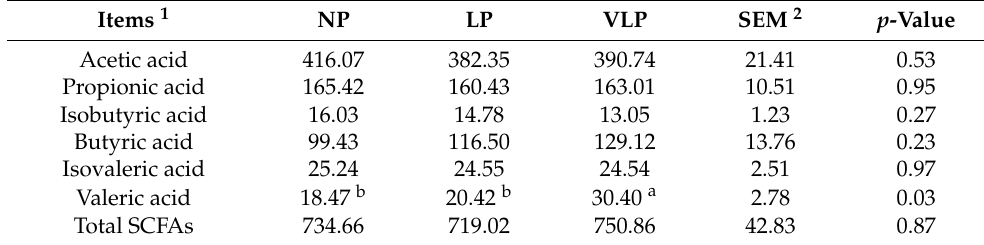
Table 3. Effect of Low-protein Diet on SCFAs content in colon of Finishing Pigs (mg/kg).